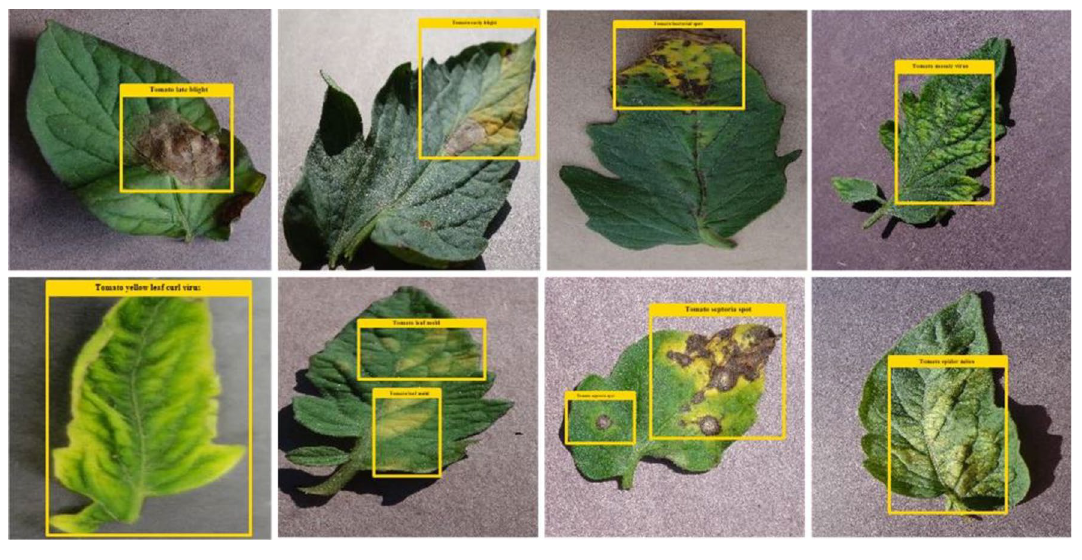
Figure 4. Annotated image